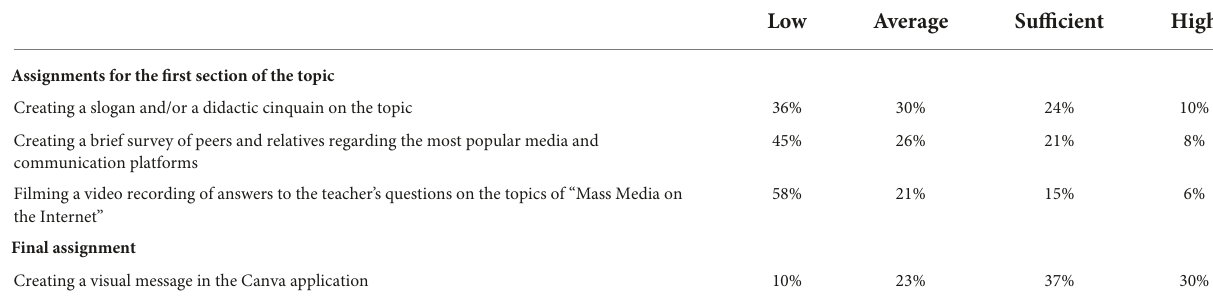
TABLE 4 Results of the thematic online marathon. Task Level of performance